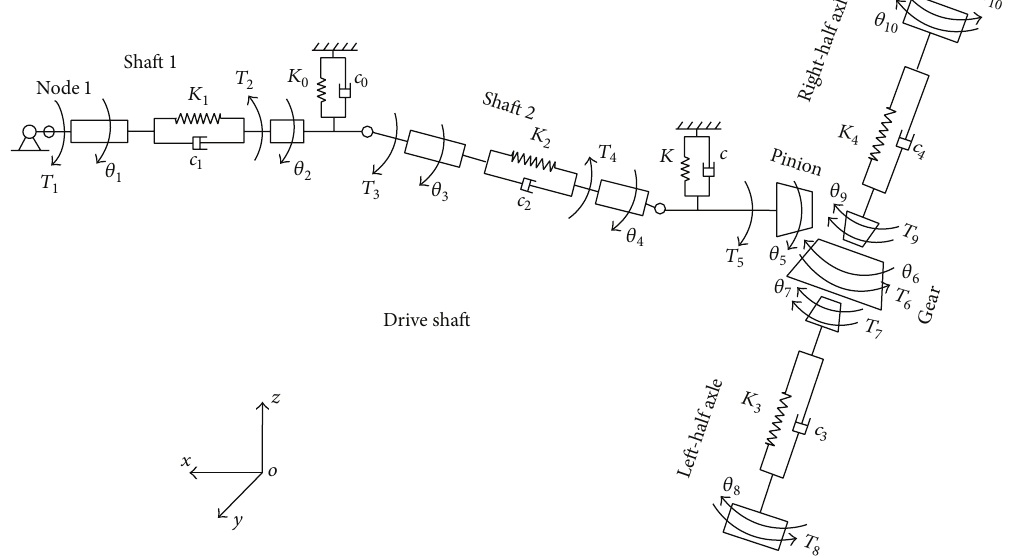
Figure 1: Mathematical model of a shaft-final drive